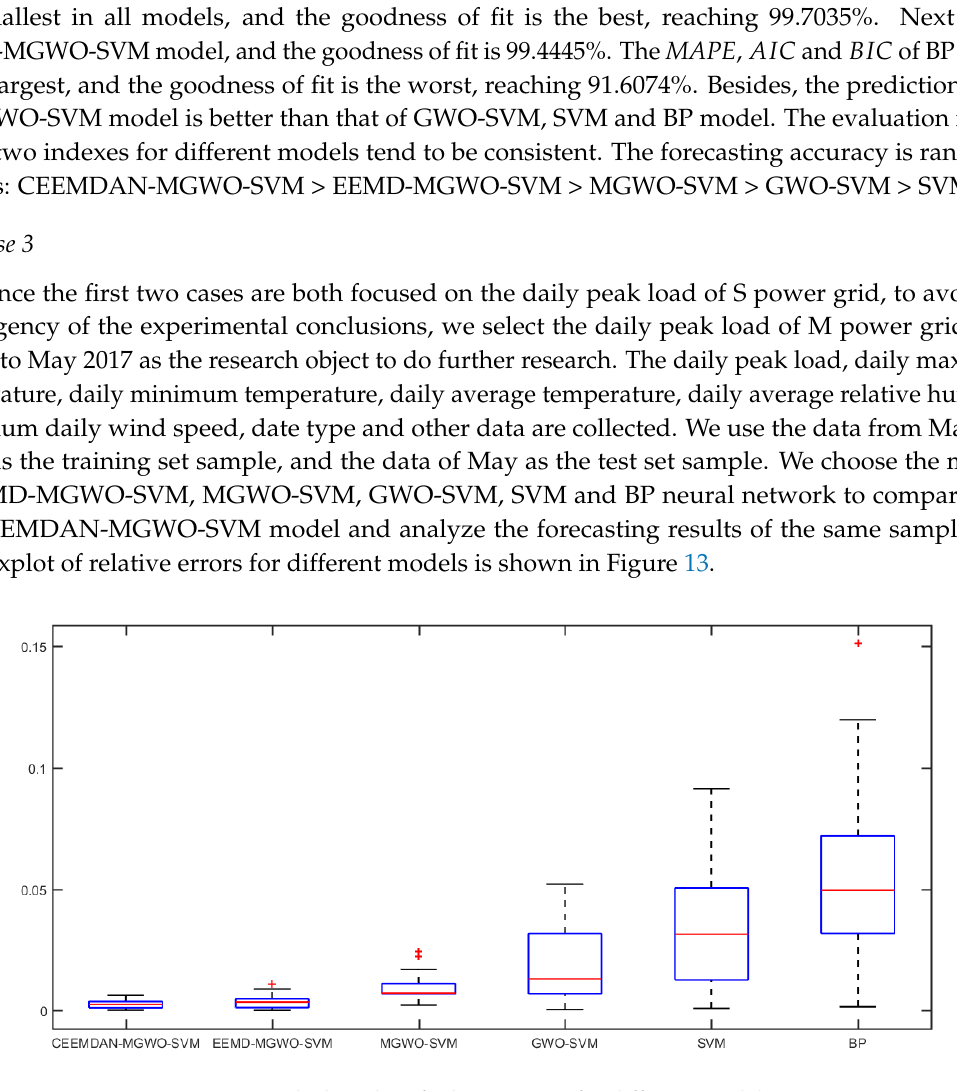
Table 8. The relative errors of the forecasting results for different models.